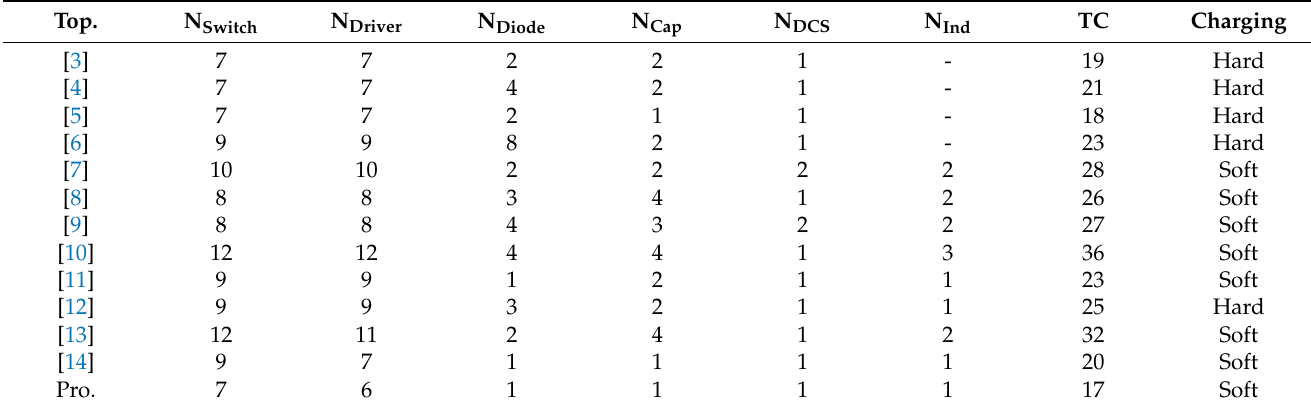
Table 2. Comparison of proposed 5L-SBI with other boost type inverters.